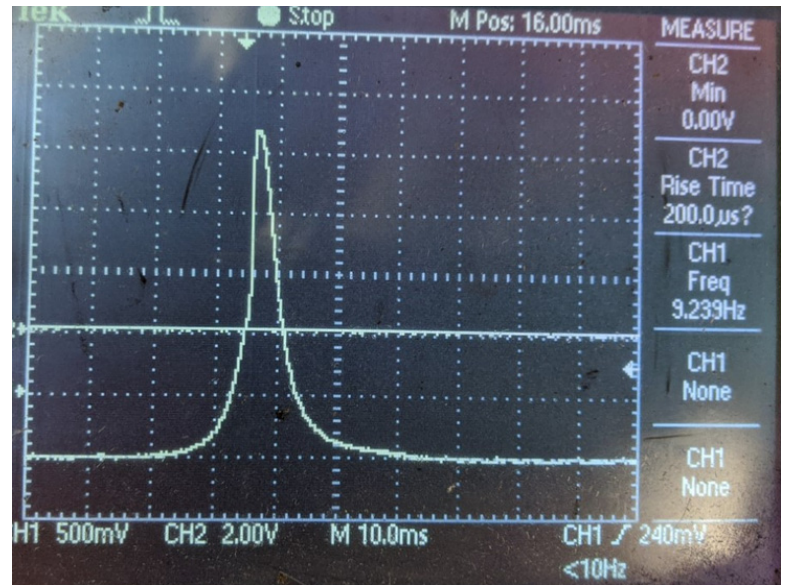
Figure A3. Motoring test on the BS, establishing its motoring pressure. The engine is revved up and the injection pump is turned off. As the engine continues to rotate, we record the peak pressure. Each division is 10 bar. The x axis scale gives us the speed estimate. The speed here is about 1050 rpm. The peak pressure will drop slightly to 750 rpm, but we are using this figure of about 27 bar gage or 28 bar absolute.